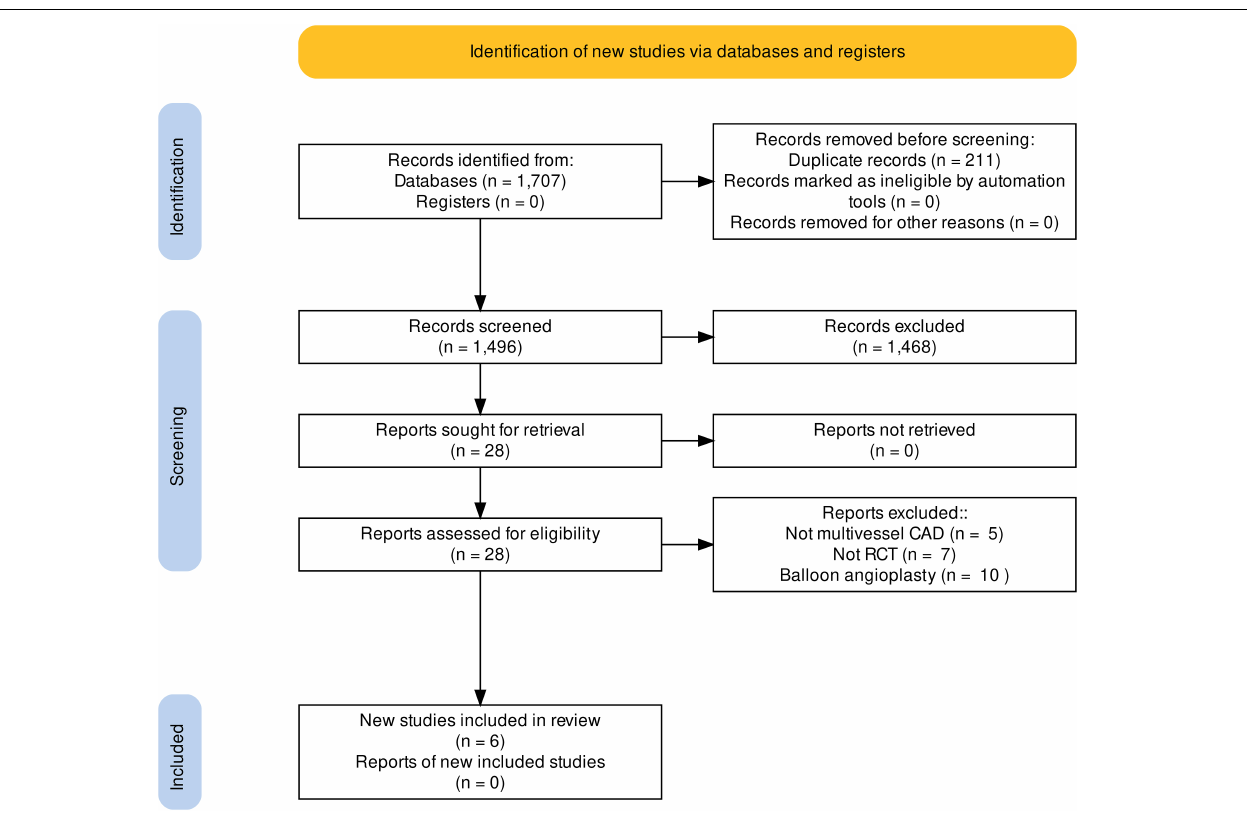
FIGURE 1 | PRISMA flow diagram. Search strategy and source of included